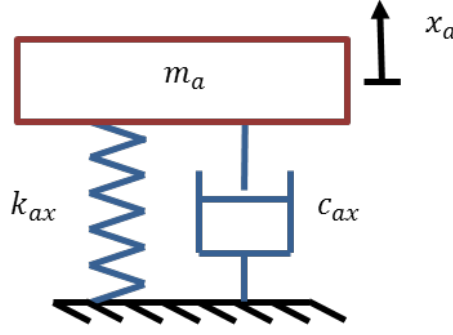
Table 3. Parameters of the designed pendulum absorbers.